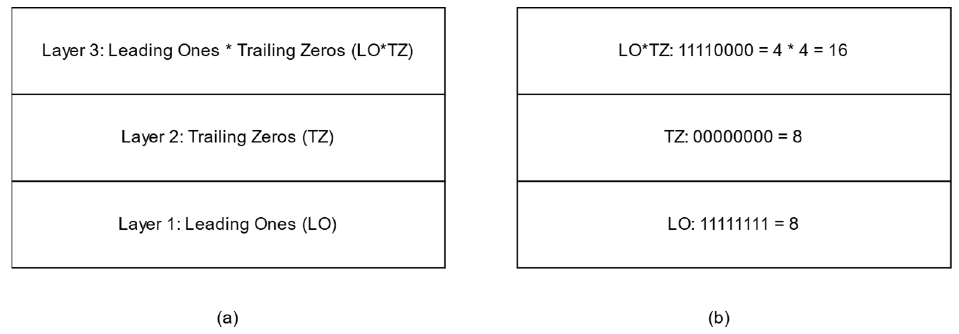
Figure 1 . Layered learning example, where the Leading Ones * Trailing Zeros problem is decom- posed into three layers ( a ). On the right ( b ), the optimum bitstring solution for each layer is dis-